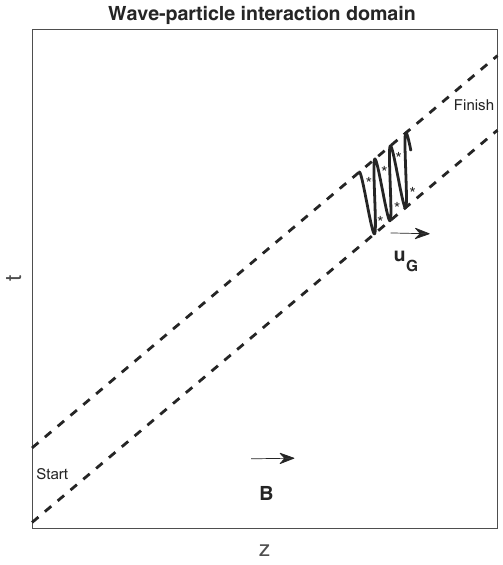
Figure 1. The resonance beam of energetic electrons (stars) and the short electromagnetic pulse (sine) move together in the domain along the corridor between the start and finish